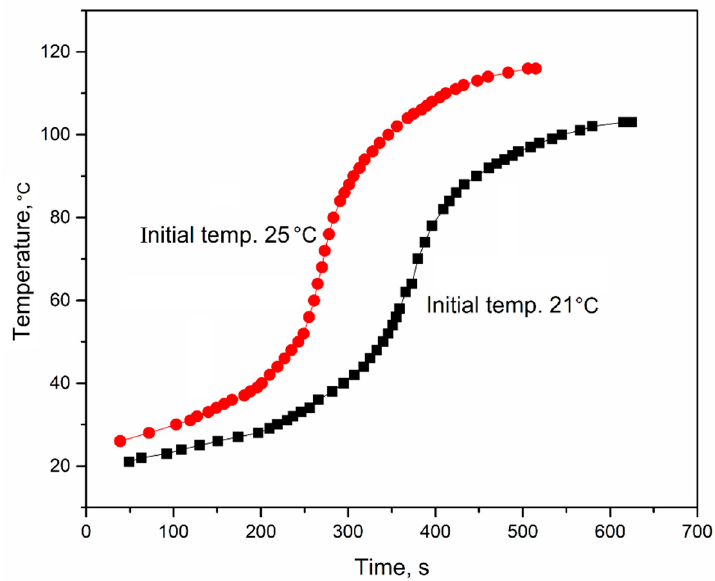
Figure 5. Inner temperature variation during the foaming process under different initial temperatures of the foaming mixture.